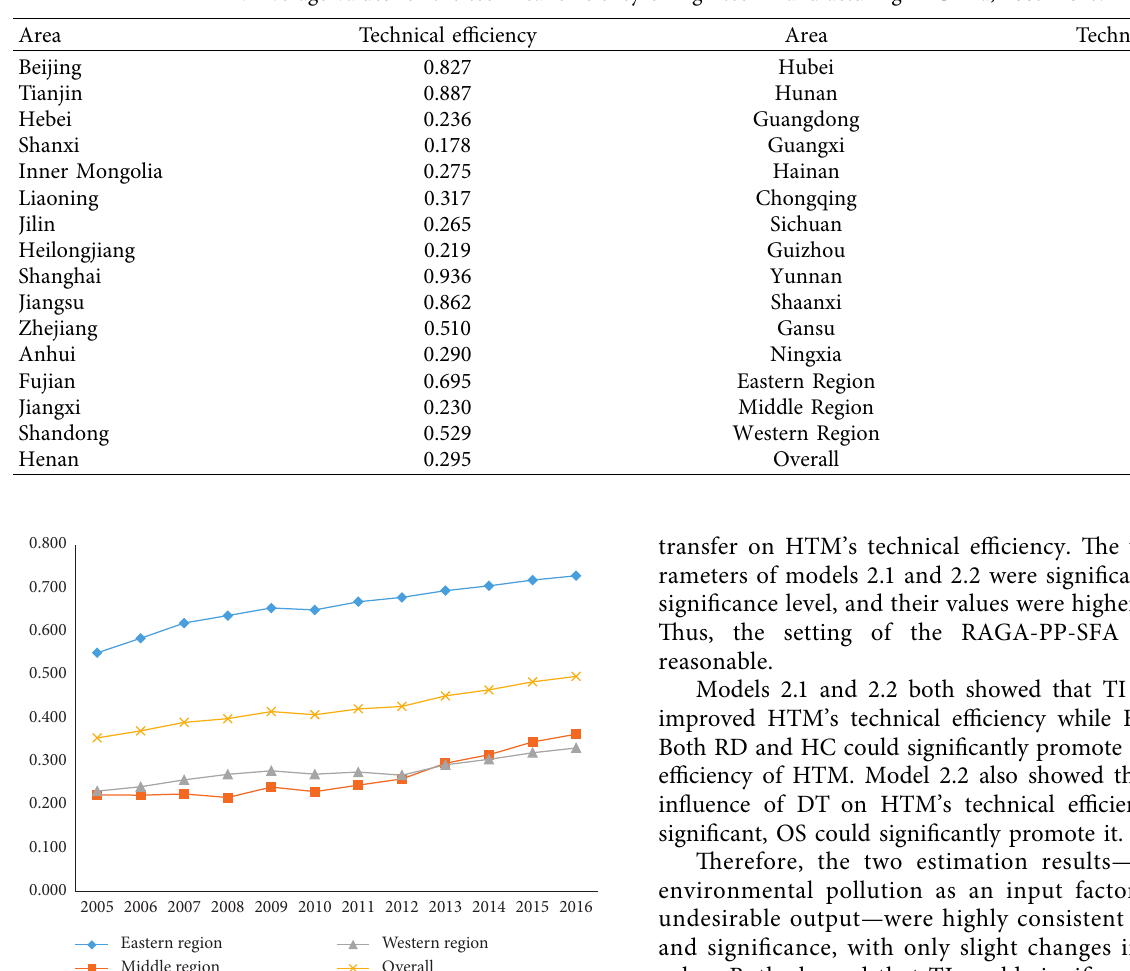
Table 4: Average values for the technical efficiency of high-tech manufacturing in China, 2005–2016.